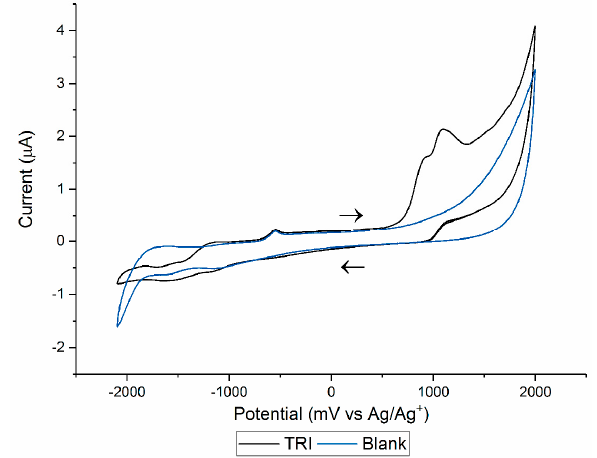
Figure 1. Cyclic voltammogram of trimethoprim (TRI) in the three-compartment electrochemical cell using a glassy carbon working electrode (2 mm of diameter) and a solution of ACN:H 2 O 99:1 and 100 mM tetrabutylammonium perchlorate (TBAP). Potential scan rate was 50 mV s − 1 . Arrows indicate the signal corresponding to the forward and reverse scans.